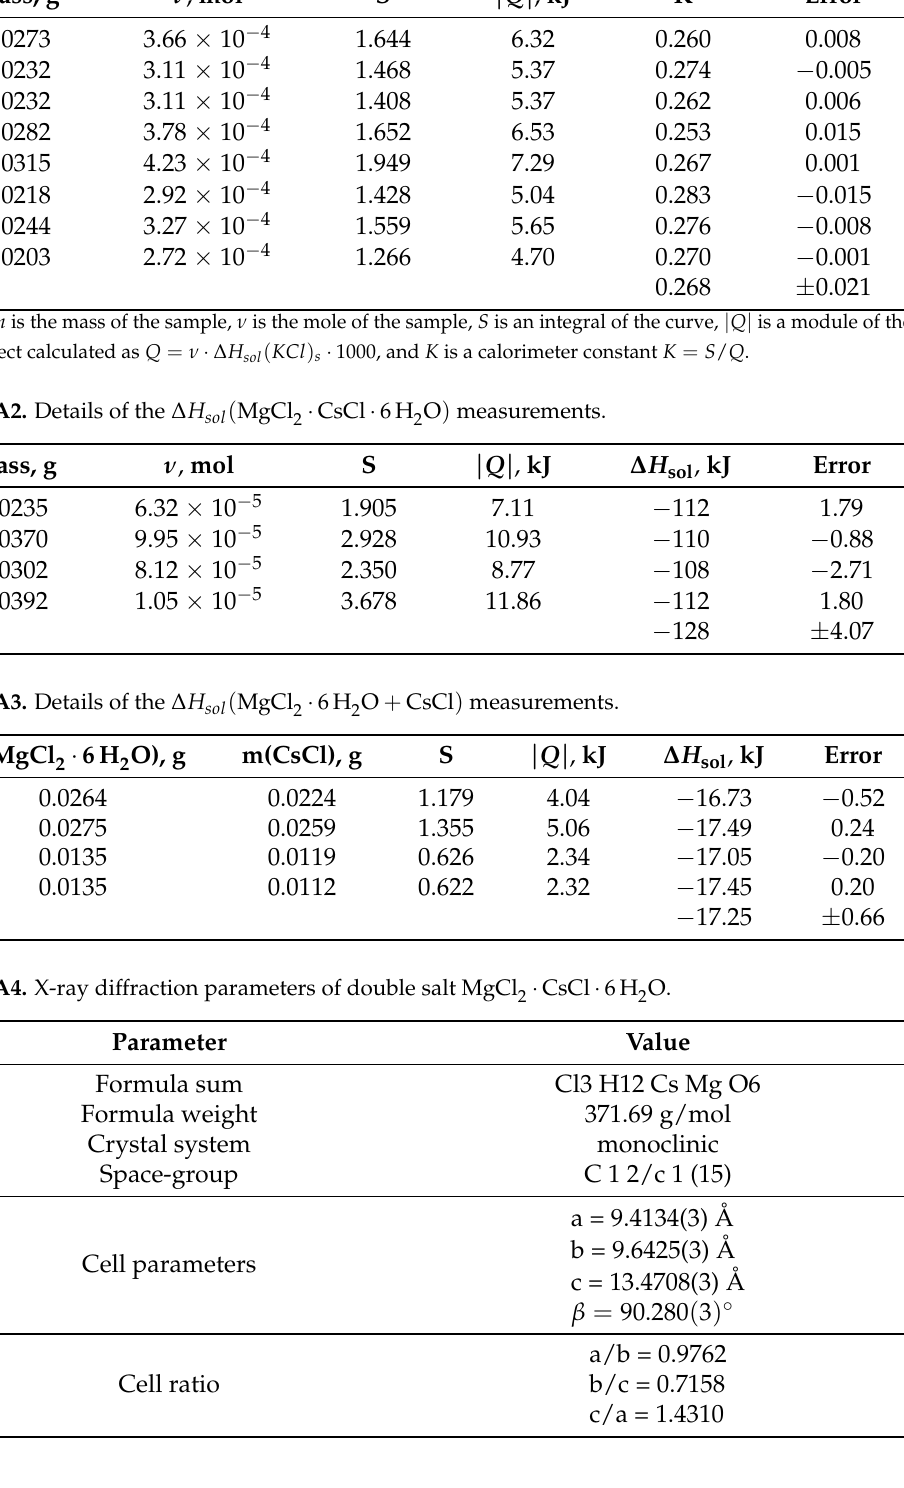
Table A1. Details of the calorimeter calibration with KCl.